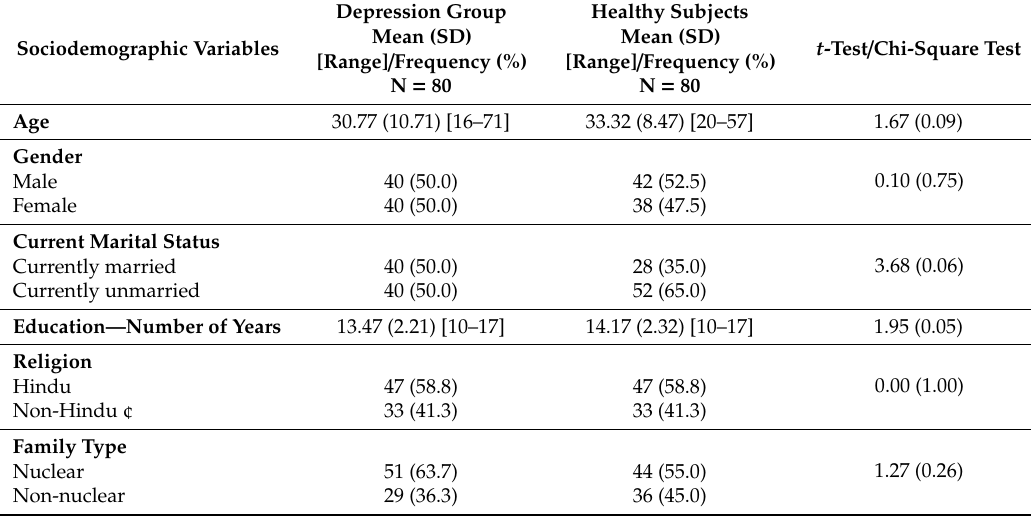
Table 1. Sociodemographic profiles of the study